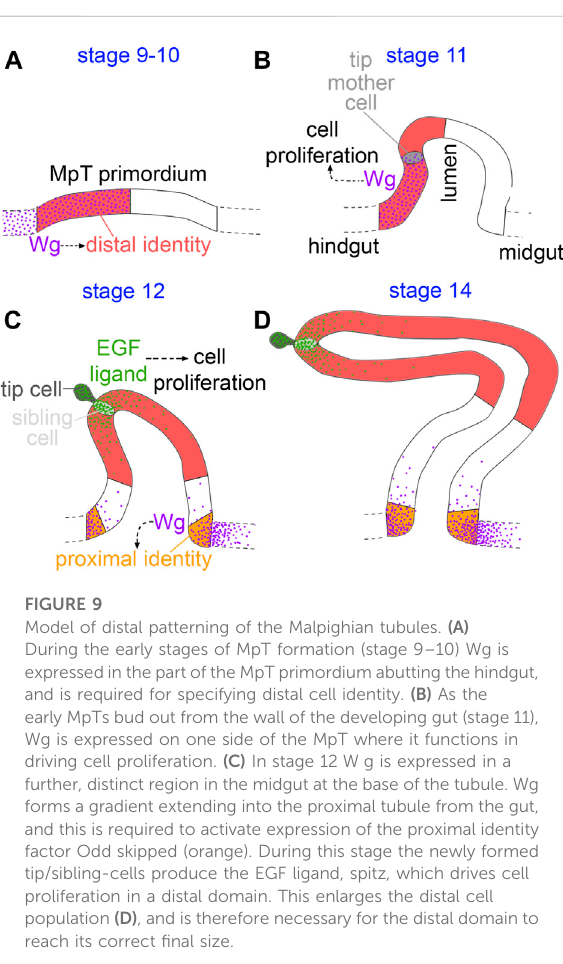
FIGURE 8 the midgut-hindgut boundary (*) from where a gradient extends into the midgut (arrow) and into the two tubule ureters (arrowheads), which branch into the anterior and posterior pairs of MpTs. Single channel images equate to region in blue box of merged image. In A the developing hindgut (hg) and midgut (mg) are indicated. Scale bar = 50 μ m. (G) A graph of the staining intensity of anti-GFP to show the distribution of Wg-GFP from the proximal tubule end. n = 4. Error bars show S.E.M.